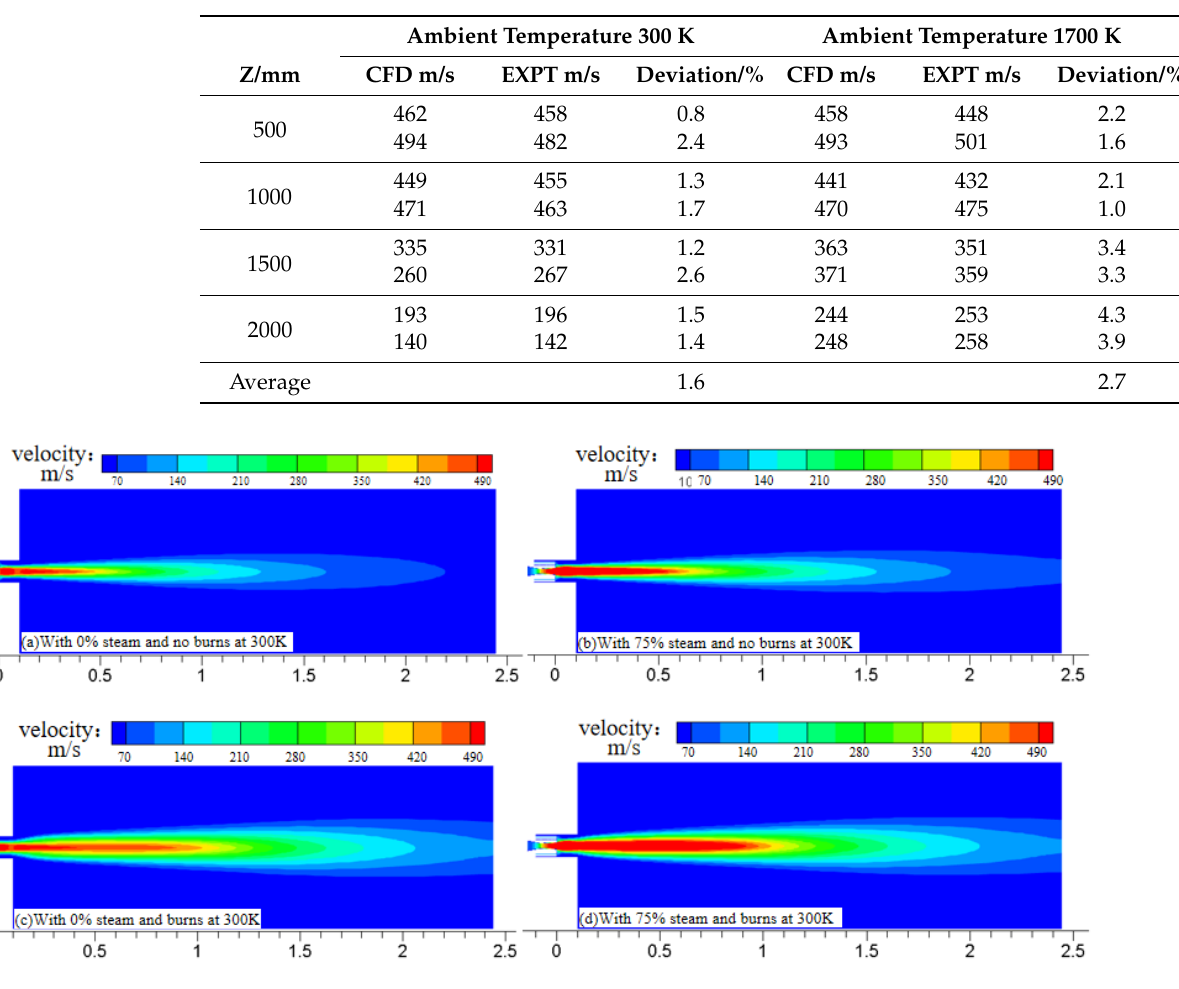
Table 3. Numerical simulation and experimental measurement of jet velocity values at ambient temperatures of 300 and 1700 K.